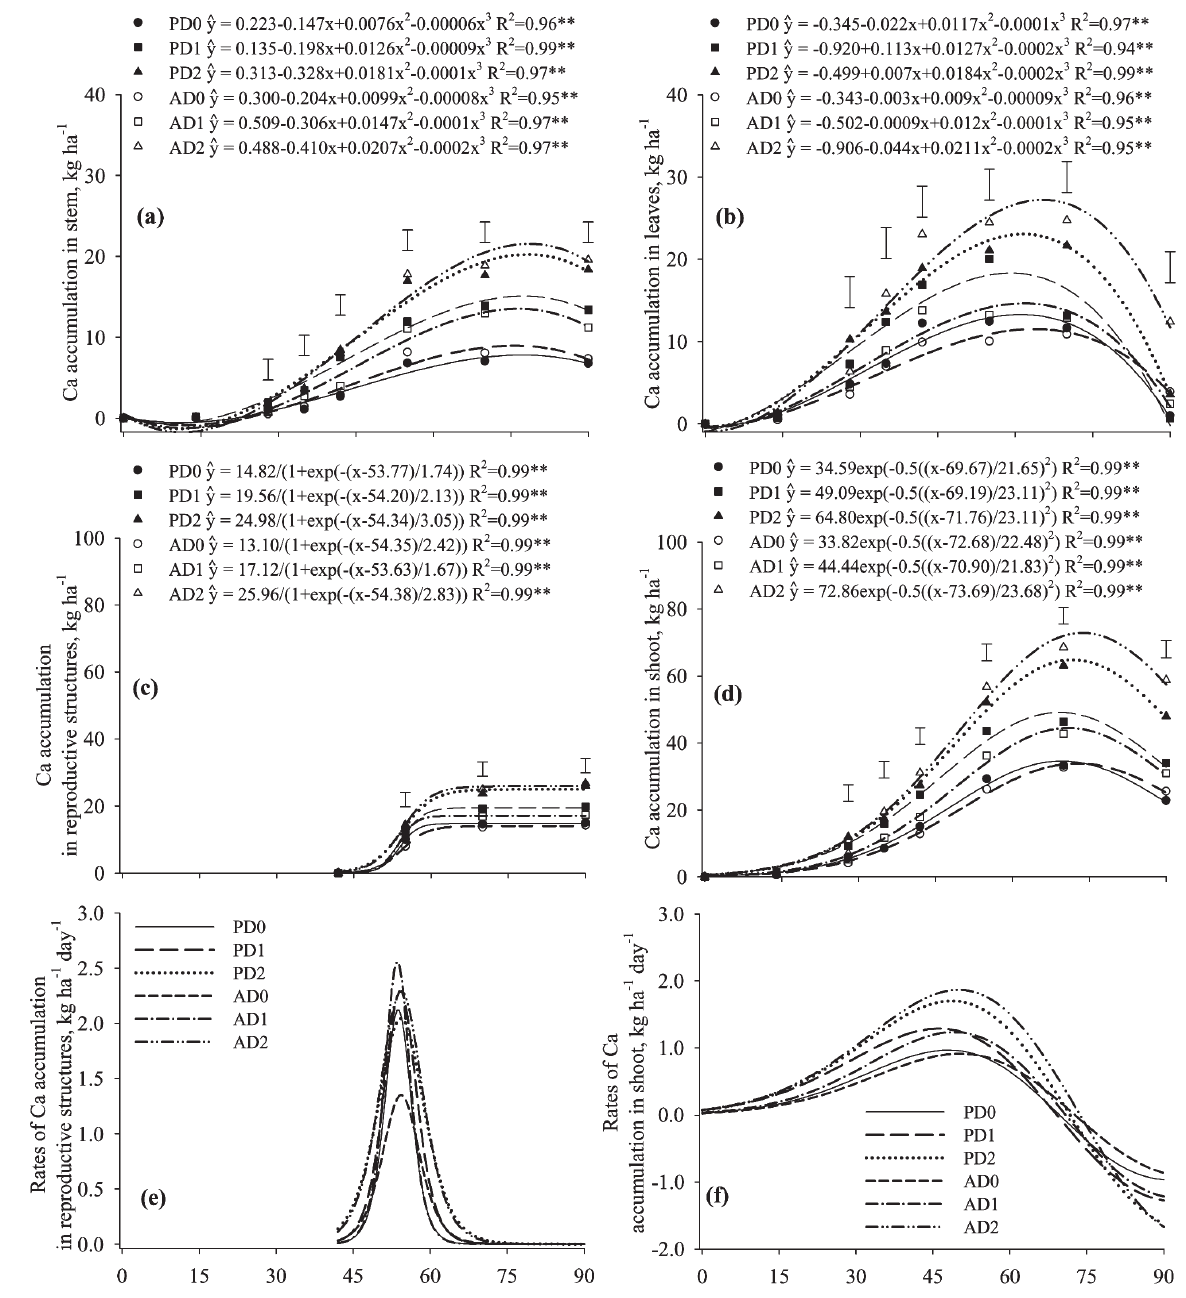
Figure 5. Calcium accumulation in stem (a), leaves (b), reproductive structures (c), and shoot (d) and rates of accumulation of Ca in reproductive structures (e) and shoot (f) of common bean cultivars, under different levels of fertilization. ** and * are: significant at p 0.01 and p 0.05 by the F test. Vertical bars represent the Least Significant Difference (LSD) at p 0.05. PD0 = Pérola without NPK fertilization, PD1 = Pérola with 50 % of recommended NPK fertilization; PD2 = Pérola with 100 % of recommended NPK fertilization; AD0 = IAC Alvorada without NPK fertilization, AD1 = IAC Alvorada with 50 % of recommended NPK fertilization; AD2 = IAC Alvorada with 100 % of recommended NPK